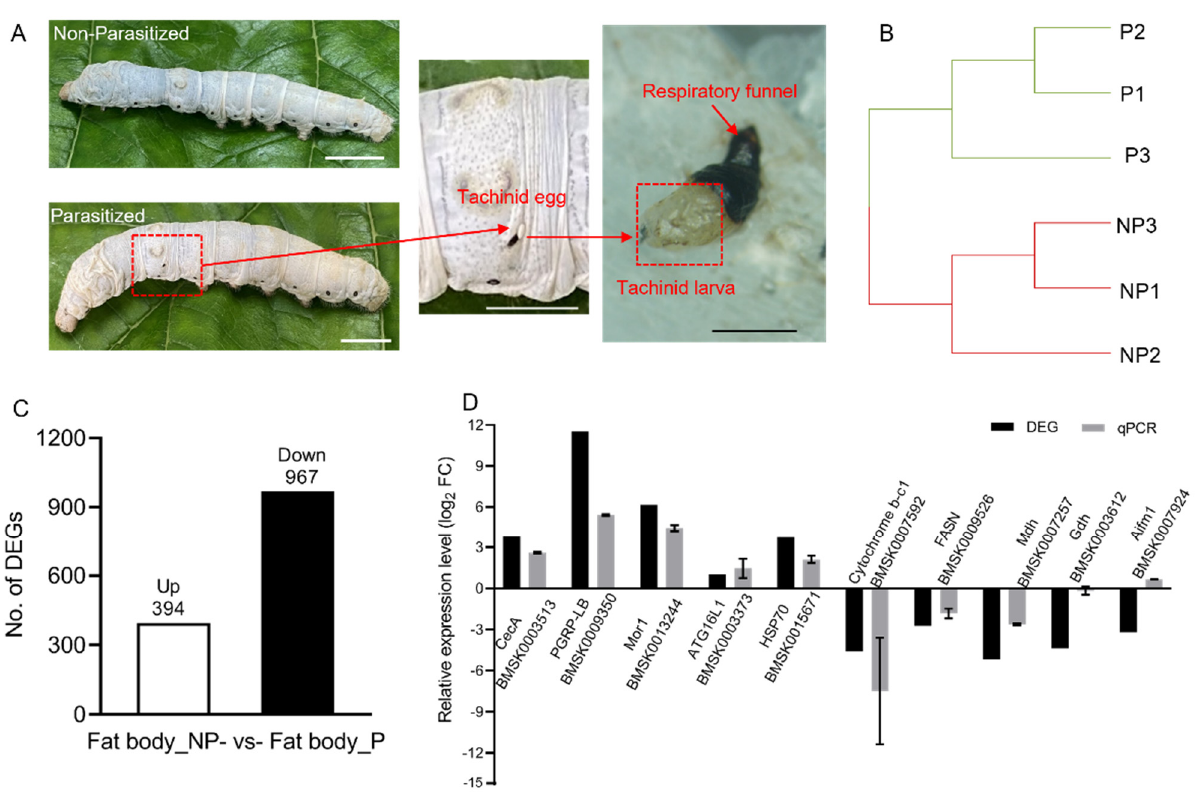
Figure 1. Global transcriptomic changes in the fat body of parasitized B. mori . ( A ) The parasitized and nonparasitized B. mori and an E. japonica larva with a respiratory funnel developed within the host. White bars, 1 cm; black bar, 100 μ m. ( B ) A cluster analysis of 6 samples. P, the parasitized silkworms; NP, nonparasitized controls. ( C ) Number of DEGs after E. japonica parasitism. Up, up-regulated genes. Down, down-regulated genes. ( D ) Validation of ten DEGs by RT-qPCR analysis. CecA , cecropin A; PGRP-LB , peptidoglycan recognition protein-LB; Mor1 , moricin1; ATG16L1 , autophagy-related protein 16-like; HSP70 , heat shock protein 70; FASN , fatty acid synthase; Mdh , malate dehydrogenase; Gdh , glutamate dehydrogenase; Aifm1 , apoptosis-inducing factor isoform X1. All transcriptional data were normalized to the expression level of Rp49 .